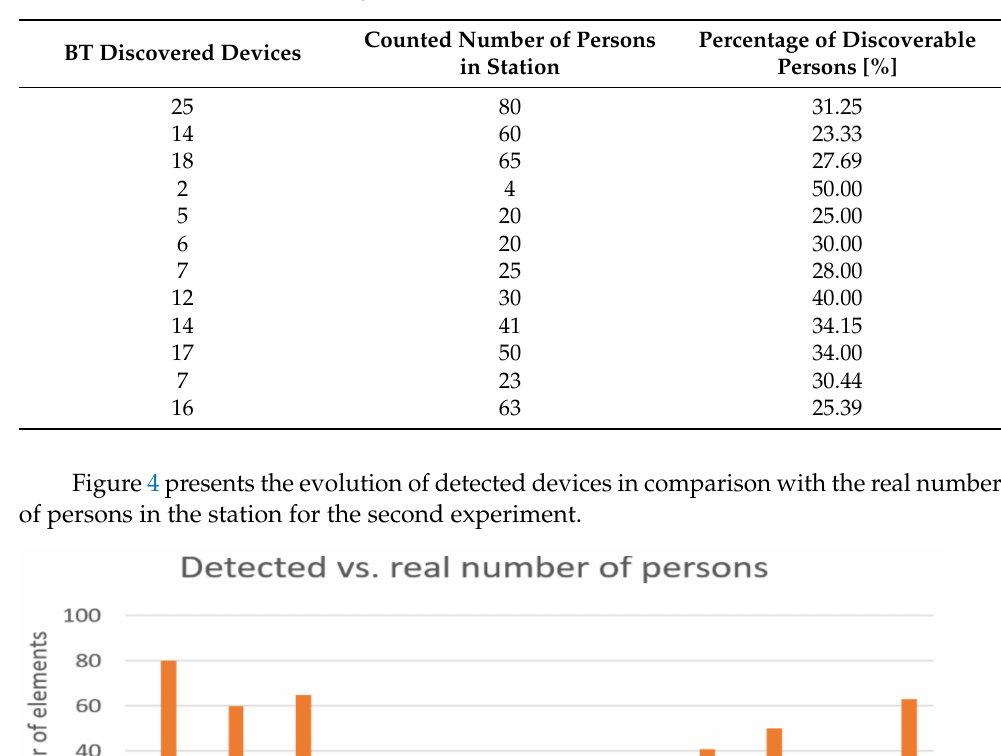
Table 3. Values recorded in Subway Station 2.